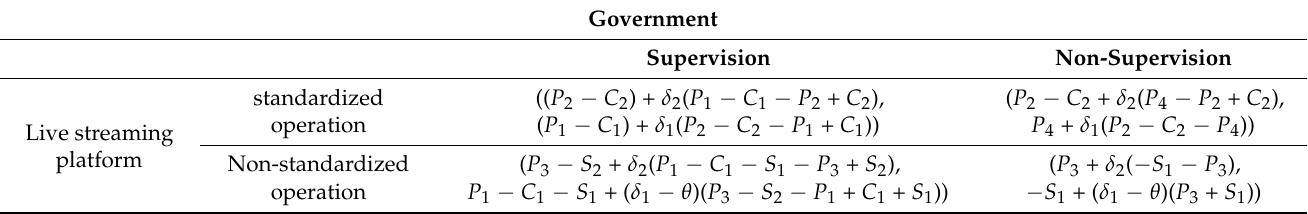
Table 8. The return and risk matrix of government and online live streaming platform.